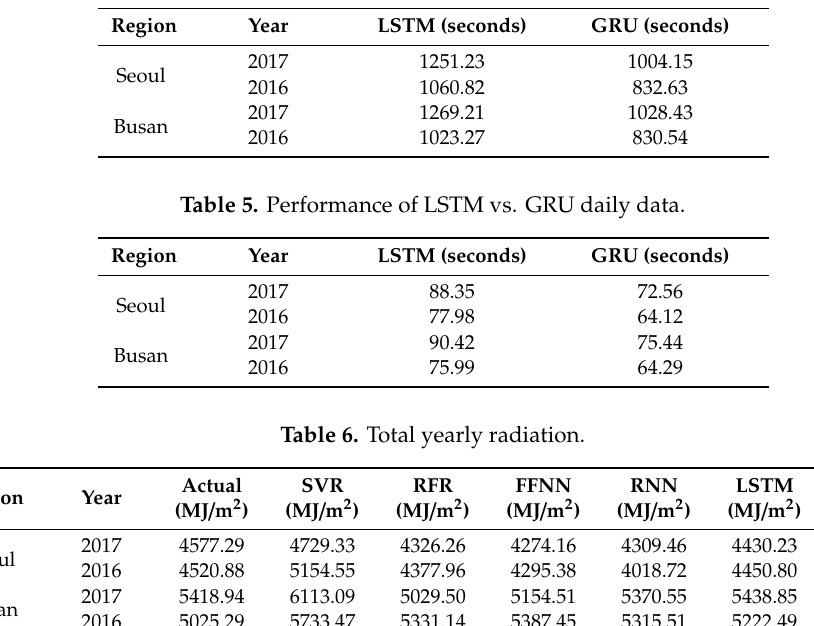
Figure 12. Comparison of RNN and its extensions in monthly time steps for Seoul Region.